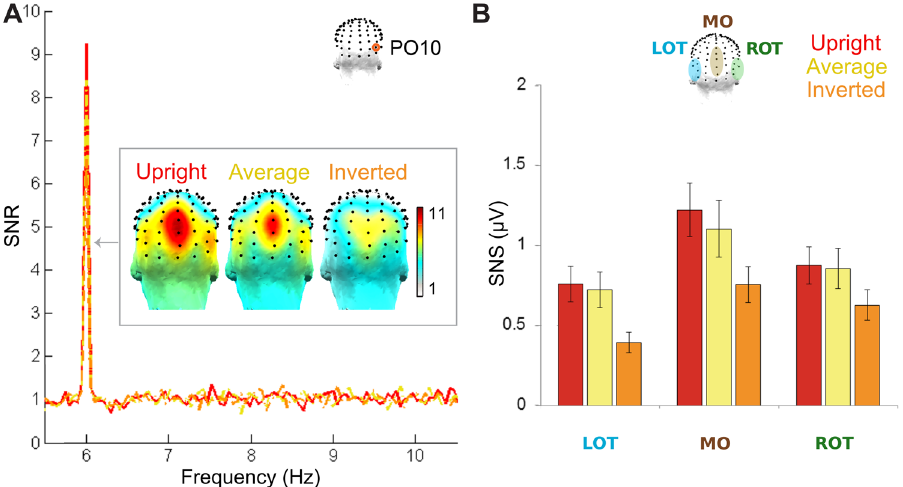
Figure 4. Symmetrical responses to the 6 Hz stimulus-presentation rate at the group level in the EEG frequency domain. ( A ) Frequency-domain signal-to-noise (SNR) spectra of a single channel (PO10, one of the channels in the right occipito-temporal (ROT) ROI) are shown for the three conditions, continued from Fig. 2A, along with the topographical scalp maps of the 6 Hz response, summed across its harmonics. The response at 6 Hz is distinct in the spectrum for all conditions. It consistently appears maximally over the medial occipital (MO) region, despite some topographical differences across conditions. ( B ) Quantification of the mean response in terms of baseline-subtracted amplitude (SNS) over each of the ROIs at 6 Hz and its five additional significant harmonics, up to 36 Hz. The response indeed occurs maximally over the MO region in all conditions, although the inverted condition shows overall lower responses and a ROT amplitude similar in amplitude to that of its MO